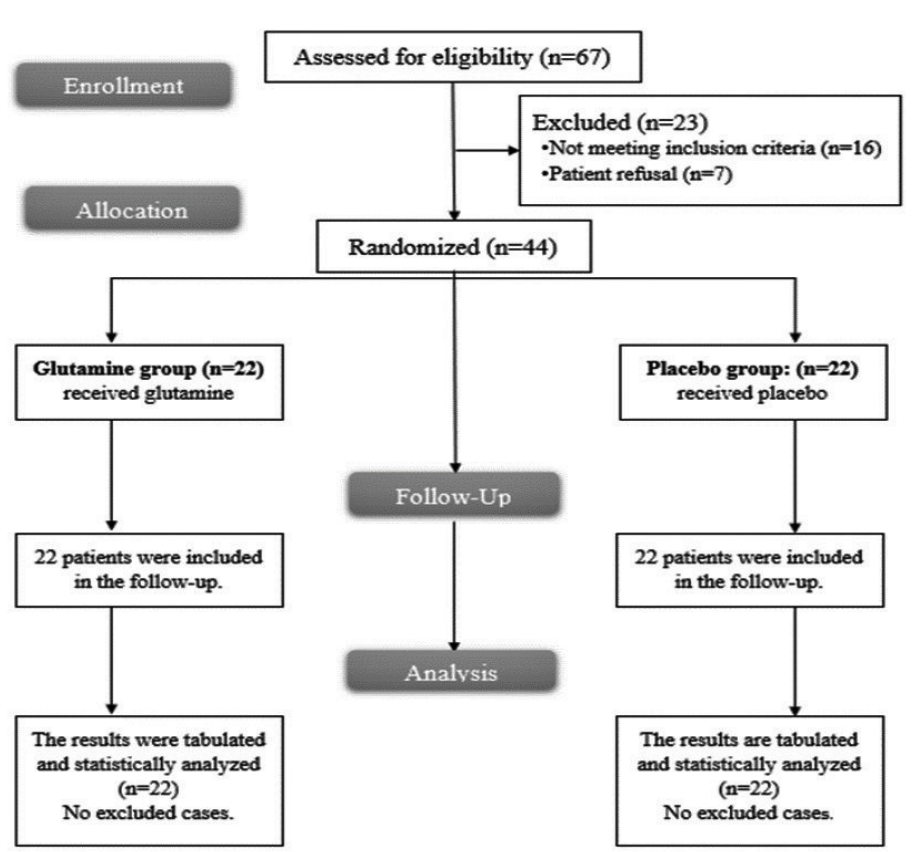
Figure 1. The randomized trial flow diagram, including enrollment, intervention allocation, follow- up, and analysis. Table 1. Patient characteristics of the studied